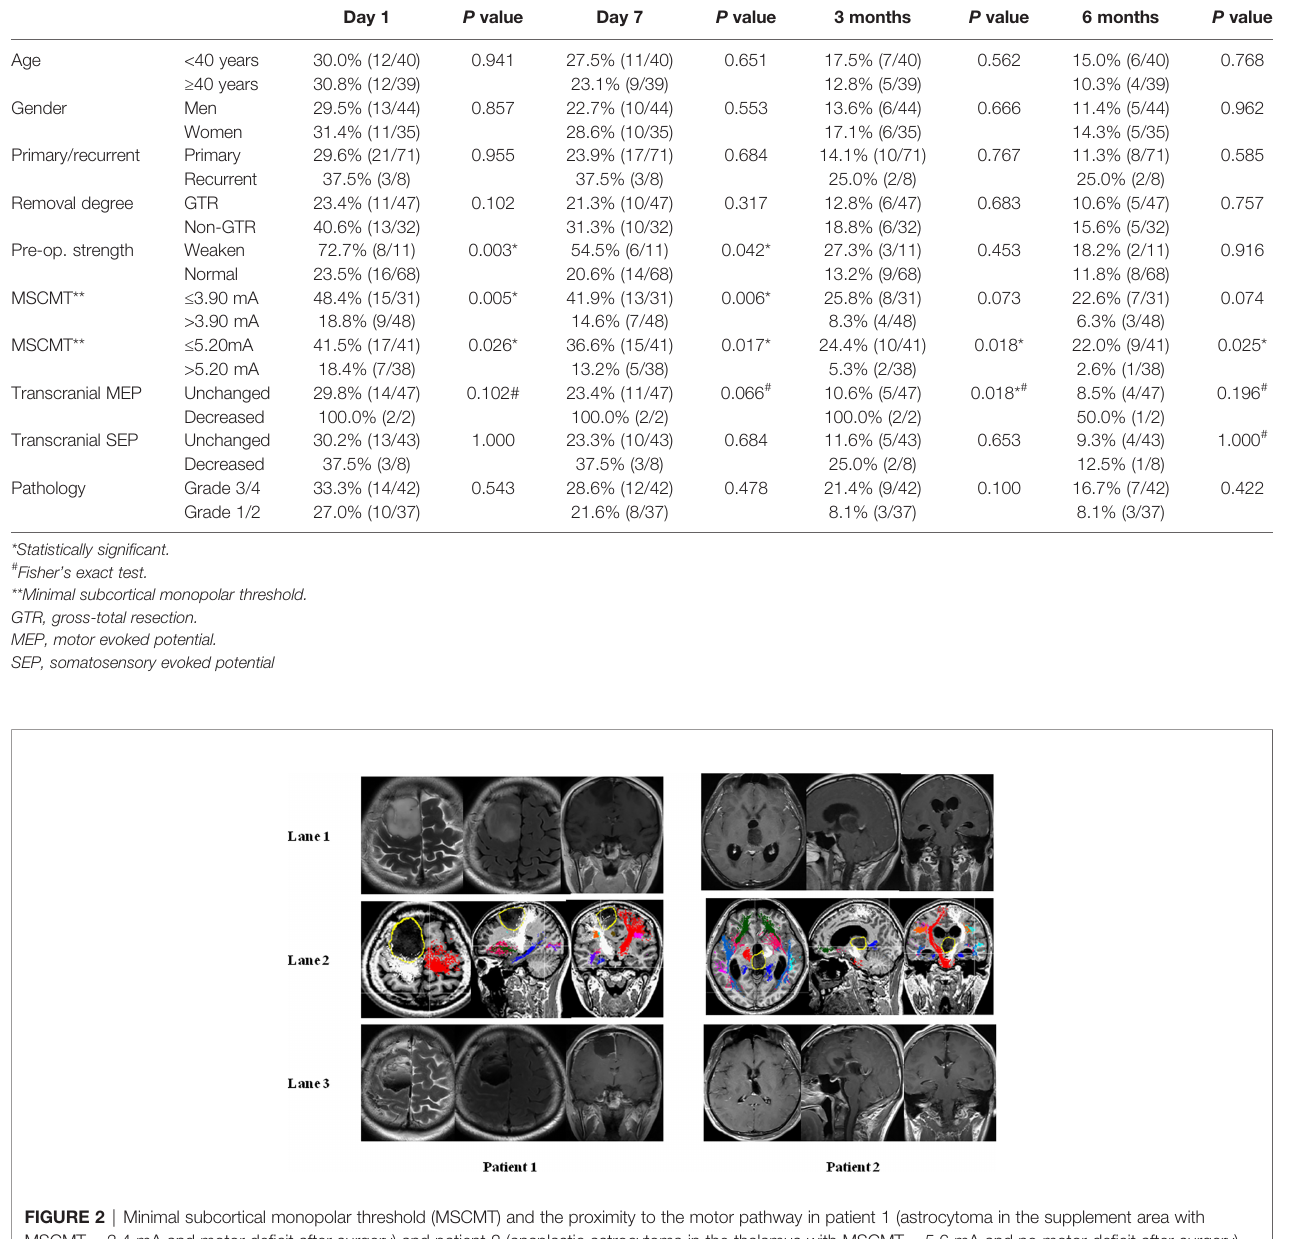
FIGURE 2 | Minimal subcortical monopolar threshold (MSCMT) and the proximity to the motor pathway in patient 1 (astrocytoma in the supplement area with MSCMT = 3.4 mA and motor de fi cit after surgery) and patient 2 (anaplastic astrocytoma in the thalamus with MSCMT = 5.6 mA and no motor de fi cit after surgery). MR images are shown in lane 1 (before surgery), lane 2 [the proximity of tumor with the pyramid tract in the diffusion tensor imaging (DTI)], and lane 3 (after